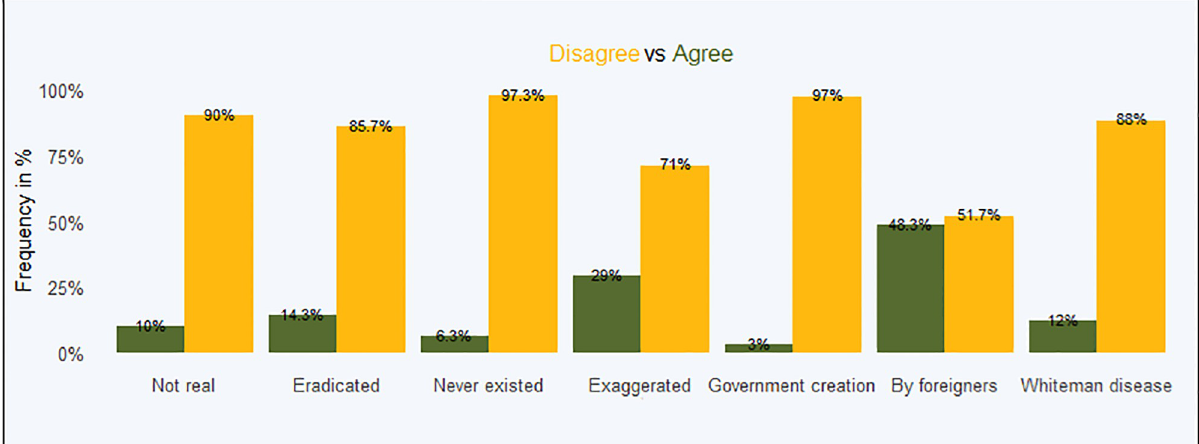
Fig 3. Overall COVID-19 conspiracy theories.